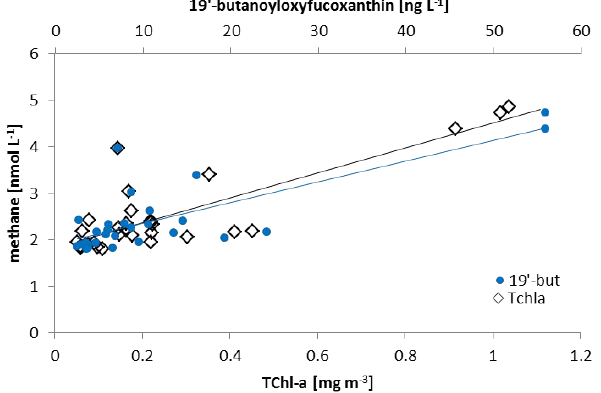
Fig. 7. Relationship between the sulphur compounds (DMSP d , DMSO p DMSO t (nmolL − 1 )) and methane (nmolL − 1 ) in the sur- face water of the north–south transit in the western Pacific Ocean. DMSP d vs methane: y = 0 . 55 x + 1 . 54, R 2 =0.57, F statistic: 43.08, p value: 1.85e − 7 , n =36; DMSO p vs methane: y = 0 . 06 x + 1 . 72, R 2 =0.37, F statistic: 17.25, p value: 2.64e − 4 , n =31; DMSO t vs methane: y = 0 . 06 x + 1 . 48, R 2 =0.42, F statistic: 22.49, p value: 4.5e-05, n